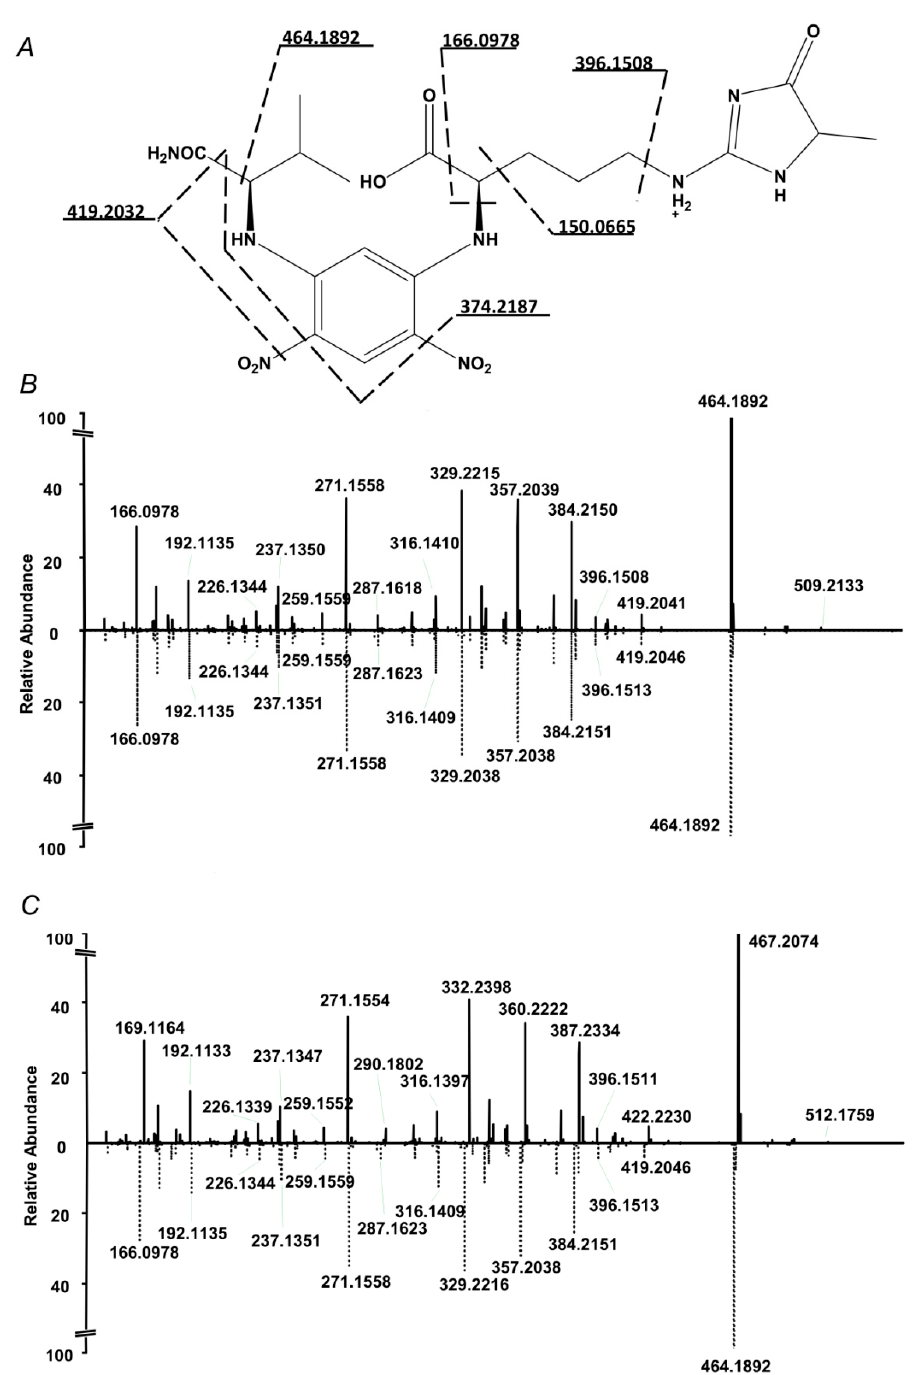
Figure 3. Fragmentation pattern of the N 2 -(5-fluoro-2,4-dinitrophenyl)- L -valine amide (L-FDVA) derivative of MG-H1 in enzymatic hydrolysates of glycated BSA ( A and B , C bottom) and its comparison with MS/MS spectrum of authentic MG-H1 ( B top) and internal MG-H1-d3 ( C top) standards.